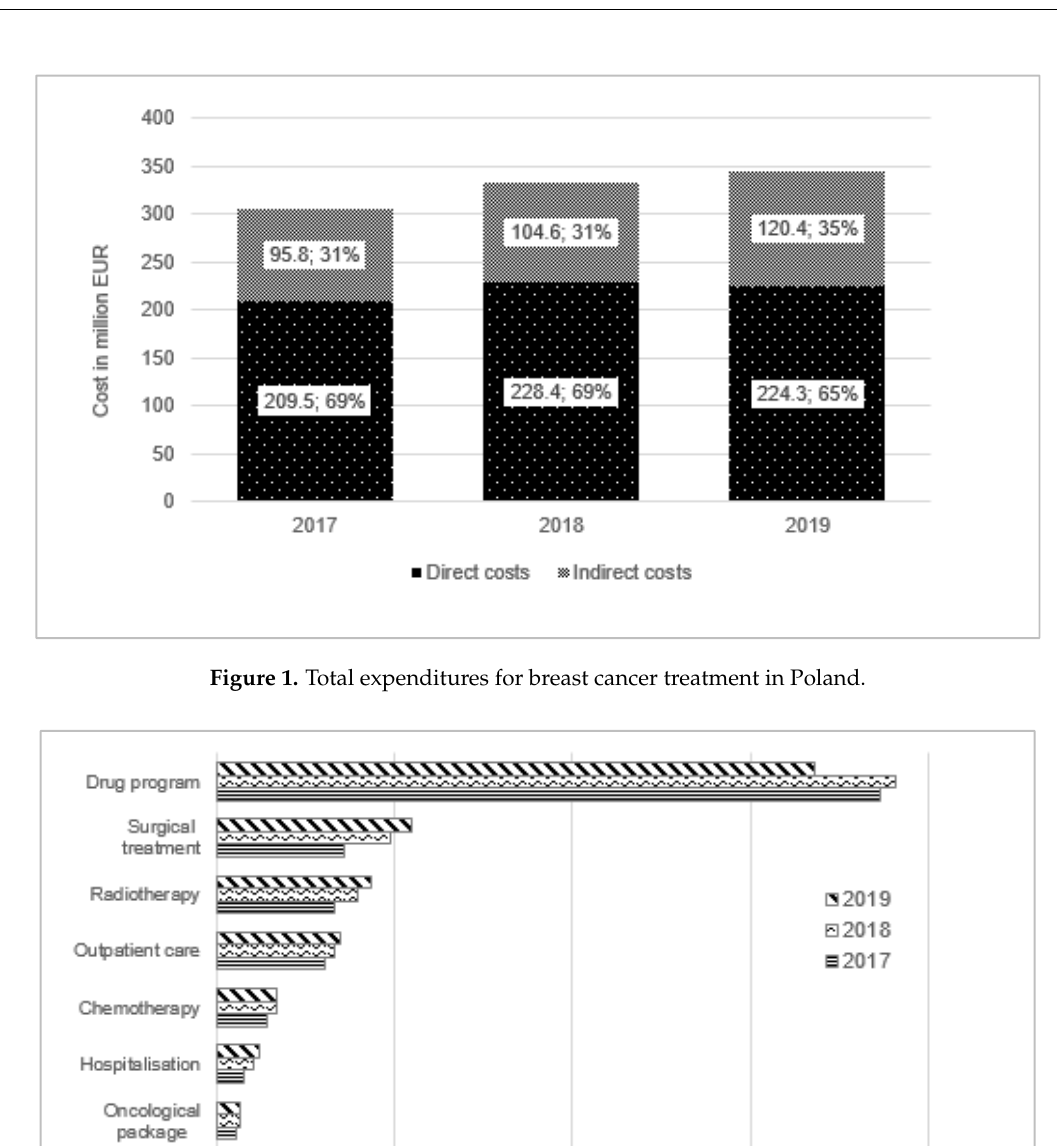
Figure 2. The direct costs of medical care of breast cancer in Poland.